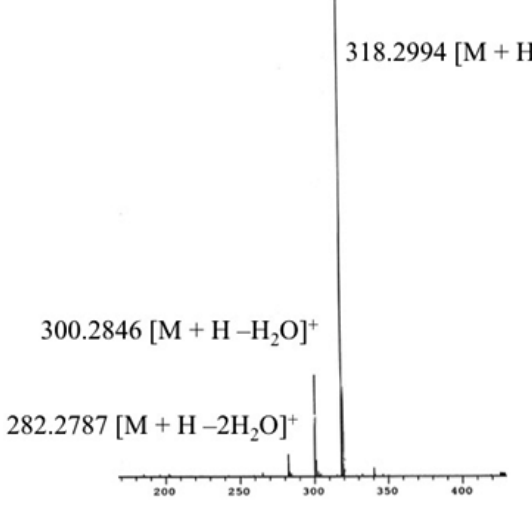
Figure 1. Standard monoelectrospray ionization mass spectrum of phytosphingosine. Increased nozzle/skimmer potentials yield neutral water